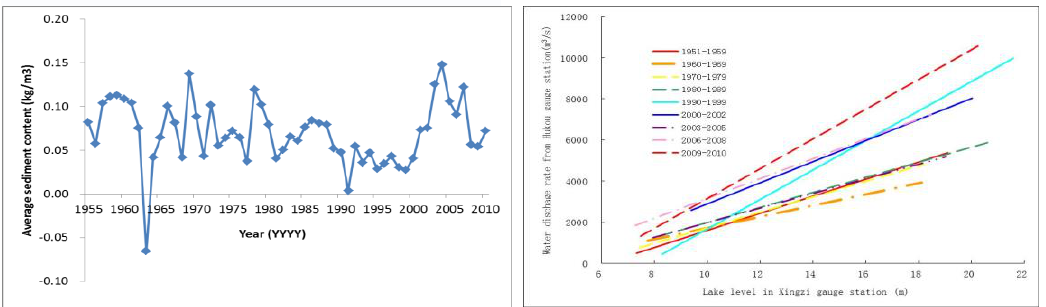
Figure 5: The morphologic changes in Poyang Lake caused by the activity of sand